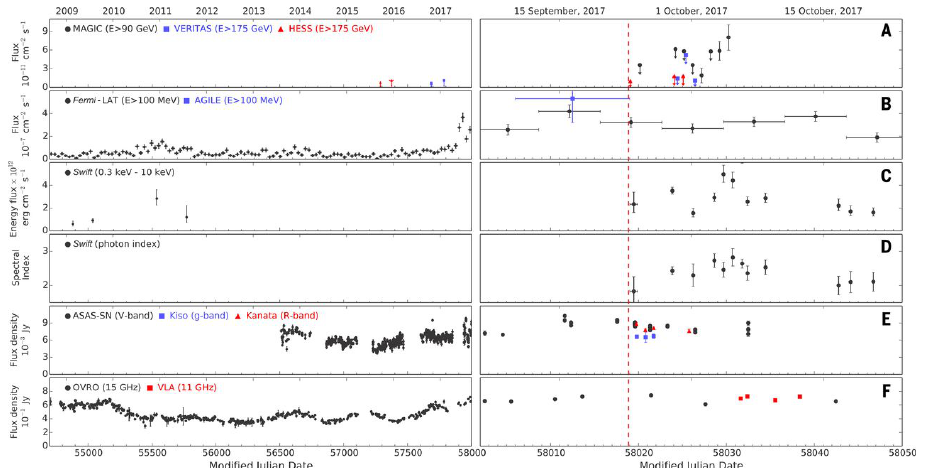
Figure 5. Multi-wavelength lightcurves of TXS 0506+056. The vertical red dashed line indicates the time of the IceCube-170922A event. Note also the absence of γ -ray activity during the period 2014–2015 of the neutrino flare. From [67]. Reproduced with permission by the American Association for the Advancement of Science